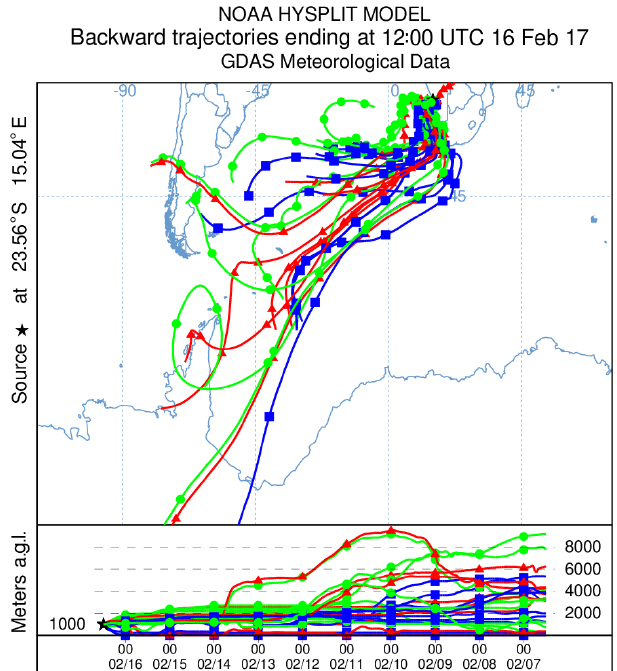
Figure 20. Same as Fig. 18 but with the endpoint of the backward trajectories at 1000m above ground